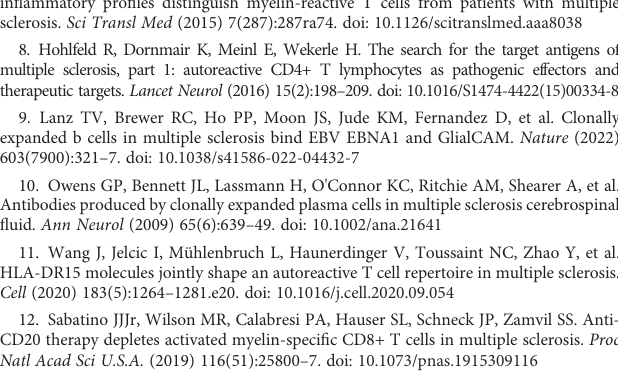
SUPPLEMENTARY FIGURE 14 Higher abundance of a memory double negative B cell subset in TMS patients during relapse. (A) FlowSOM generated metaclusters for the B cell lineage projected on the tSNE map. (B) Heatmap showing, for each of the metaclusters generated, the average intensity of each B cell related marker (stage or activation marker). A tentative biological name was assigned to each metacluster based on the most abundant B cell related marker expressed by each cluster. (C) MS patients strati fi ed in different disease subgroups (PPMS; n=9,RRMS;n=9,TMS;n=10).RRMSandTMSwerefurthersubdividedinthosein remission(RRMS;n=4, TMS;n=5)andrelapse(RRMS;n=5,TMS;n=5).Box-plots show frequencies (%) of the indicative cell types. Each dot represents the value of each sample. p < 0.05 was considered signi fi cant, non-parametric Kruskal Wallis test with correction for multiple comparisons (FDR) was applied. PPMS, Primary Progressive Multiple Sclerosis; RRMS, Relapsing Remitting Multiple SUPPLEMENTARY FIGURE 15 tSNE plots of one TMS patient during relapse and after anti-CD20 treatment. TMS, Tumefactive Multiple Sclerosis; CCR2 or CD192, C-C chemokine receptor type 2; TNF- a , tumor necrosis factor alpha; IL-6, Interleukin 6. SUPPLEMENTARY FIGURE 16 Schematic representation of cell-types differentially expressed in peripheral blood as revealed by broad immunophenotyping with CyTOF analysis. The cross-talks among cell types are based on statistically signi fi cant correlations as revealed by correlation matrix among all of immune subsets in relapsing MS (RRMS and TMS) patients as shown in . The image is hypothesis driven and implicates different cell drivers in different clinical subtypes of MS patients. PPMS, Primary Progressive Multiple Sclerosis; RRMS, Relapsing Remitting Multiple Sclerosis; TMS, Tumefactive Multiple